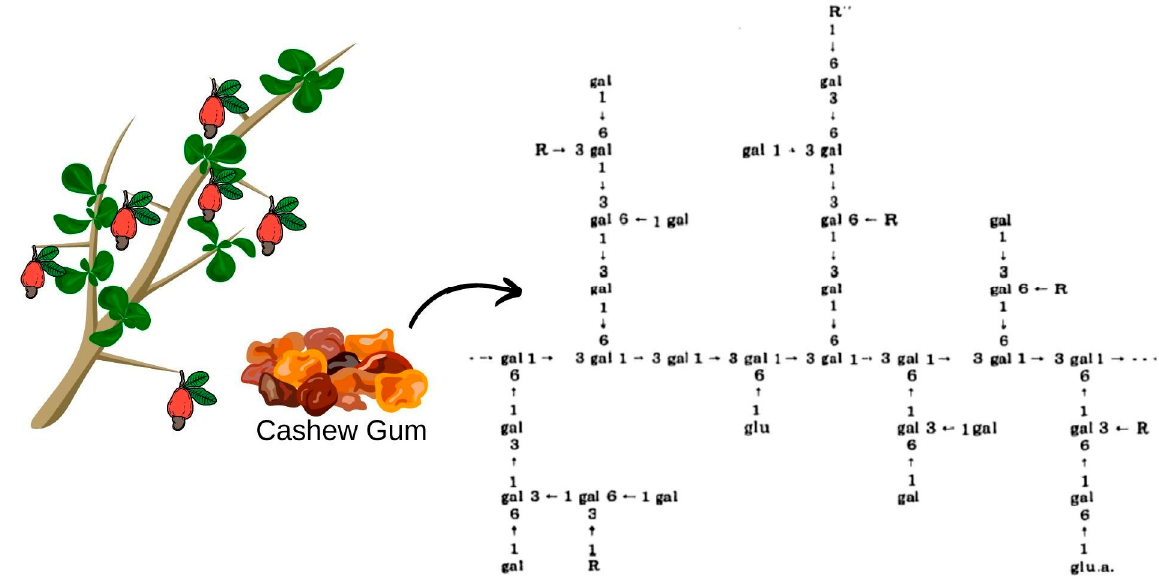
Figure 2. Possible structure of Anacardium occidentale gum, L. R represents D-mannose, D-xylose, L-rhamnose, L-arabinose or 1–2 linkage with the arabinose chain. R” represents D-glucose or D-glucuronic acid.